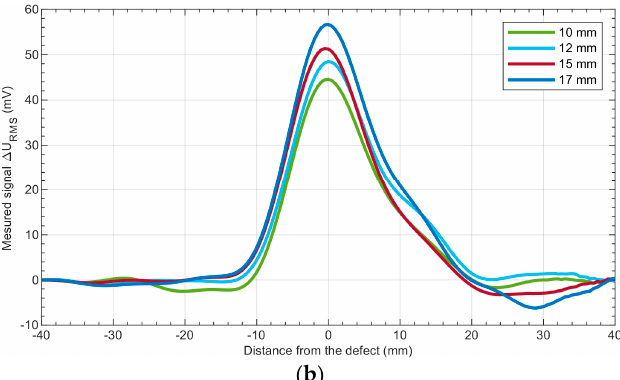
Figure 6. Results of the measurements obtained for aluminum samples—a comparison of the signals (Root Mean Square values—RMS) for different depths of the notches: ( a )—2–8 mm, ( b )—10–17 mm. The angular speed of the head was 3700 rpm.